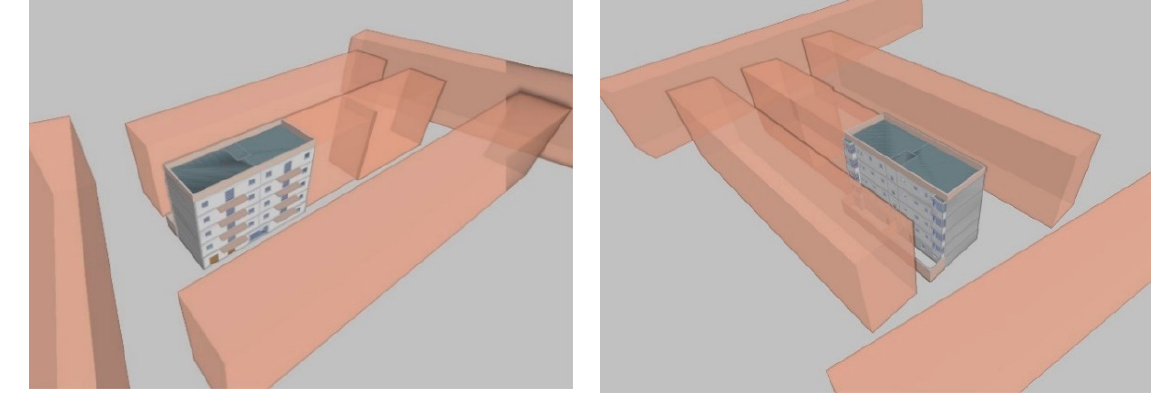
Figure 7. Model developed for the energy performance assessment in 3D.